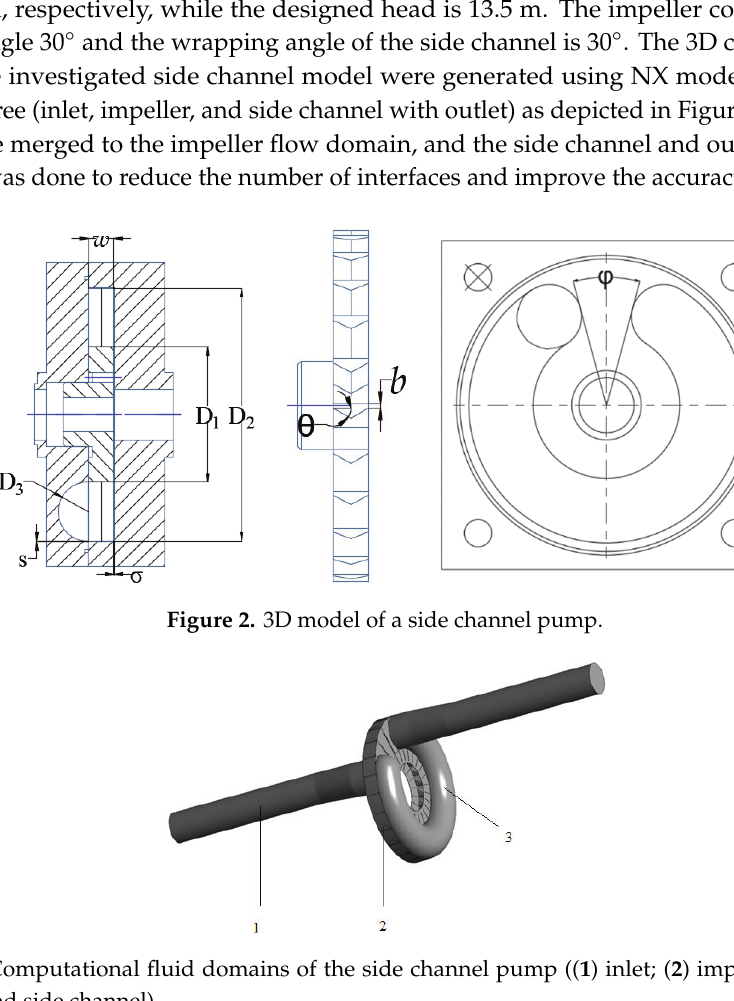
Figure 3. Computational fluid domains of the side channel pump (( 1 ) inlet; ( 2 ) impeller and gaps; ( 3 ) outlet and side channel). ( 3 ) outlet and side